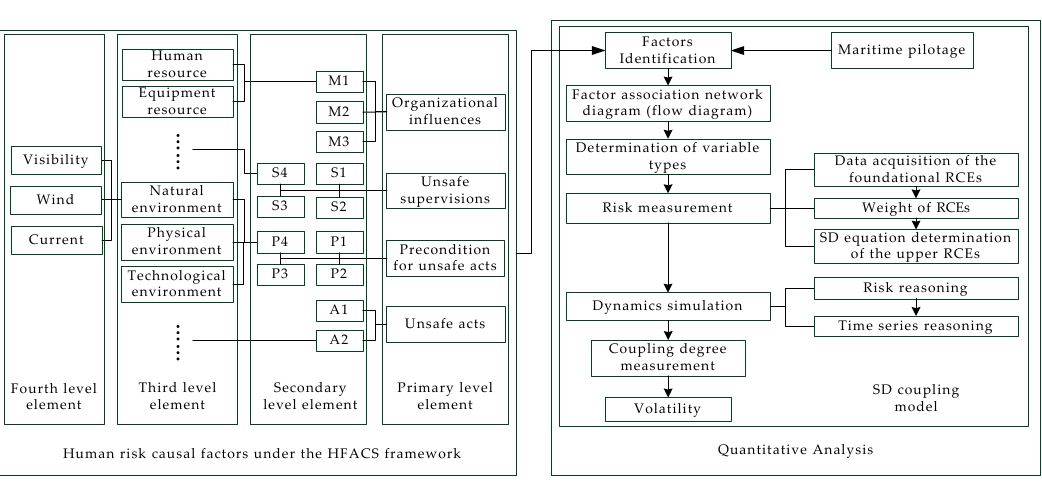
Figure 2. Research framework.